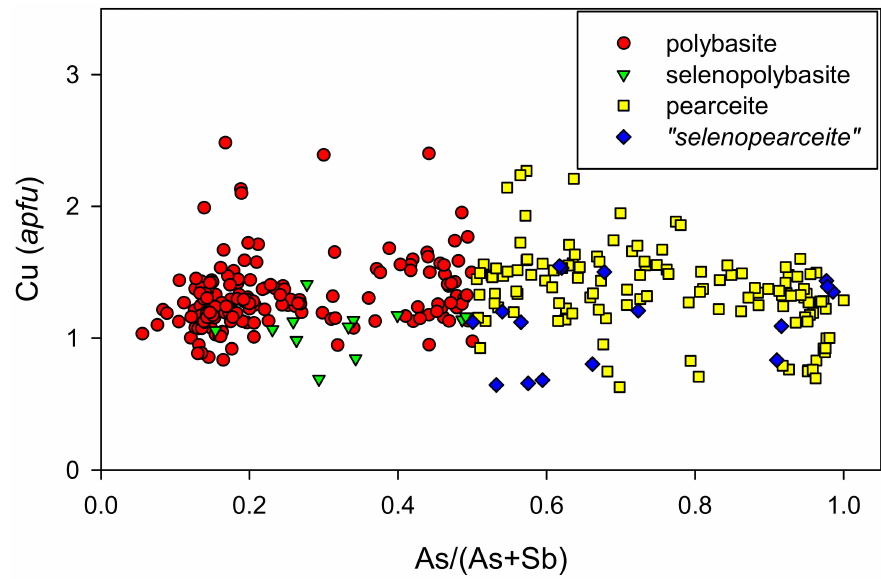
Figure 18. Graph of As/(As + Sb) vs. Cu ( apfu ) for members of the polybasite group from the Kremnica